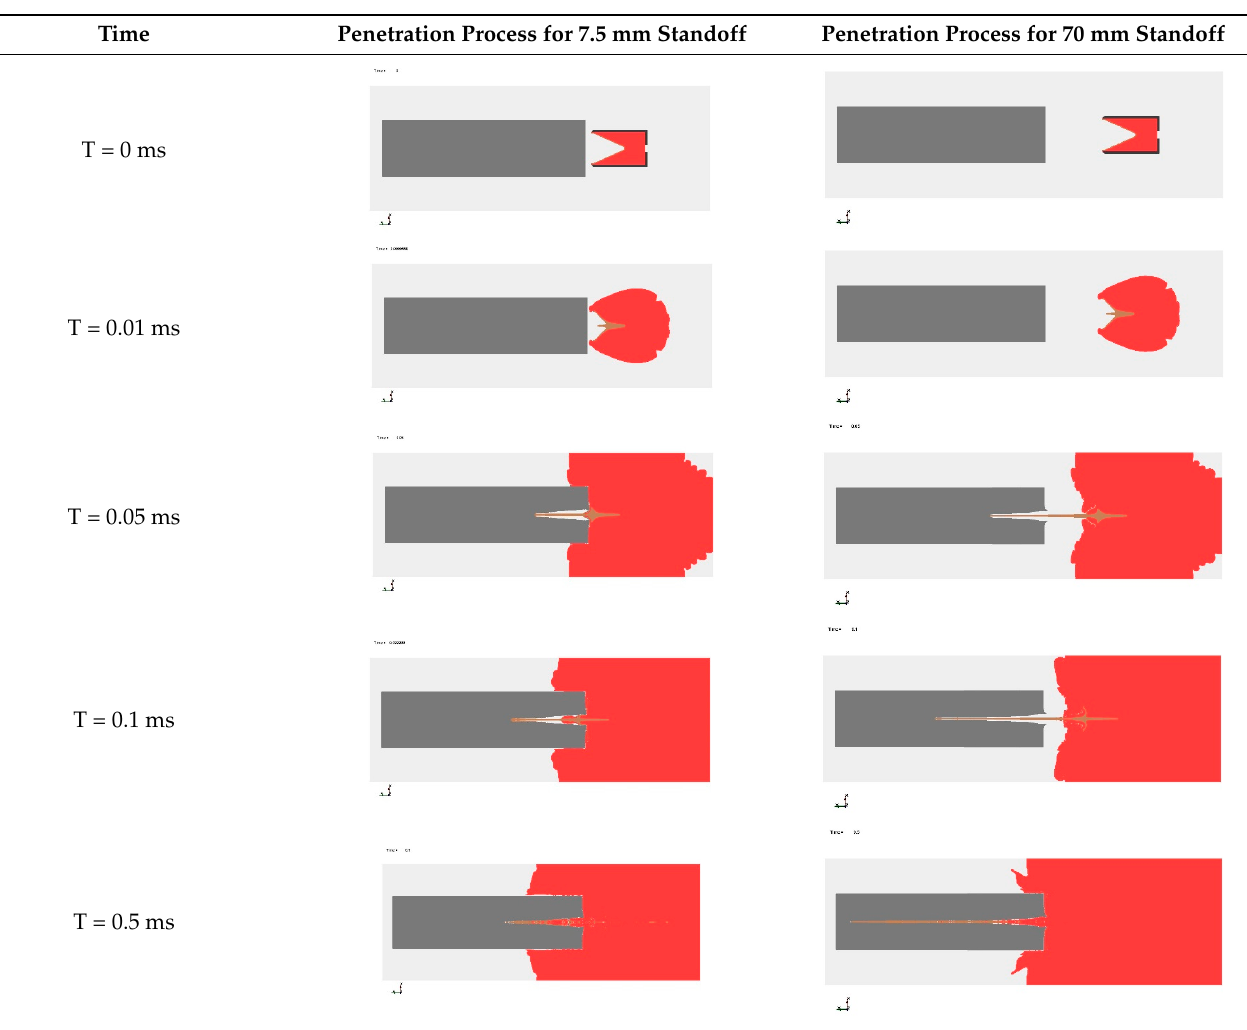
explicit type of algorithm was used to solve the structure dynamics equations in the non- linear range. linear range.